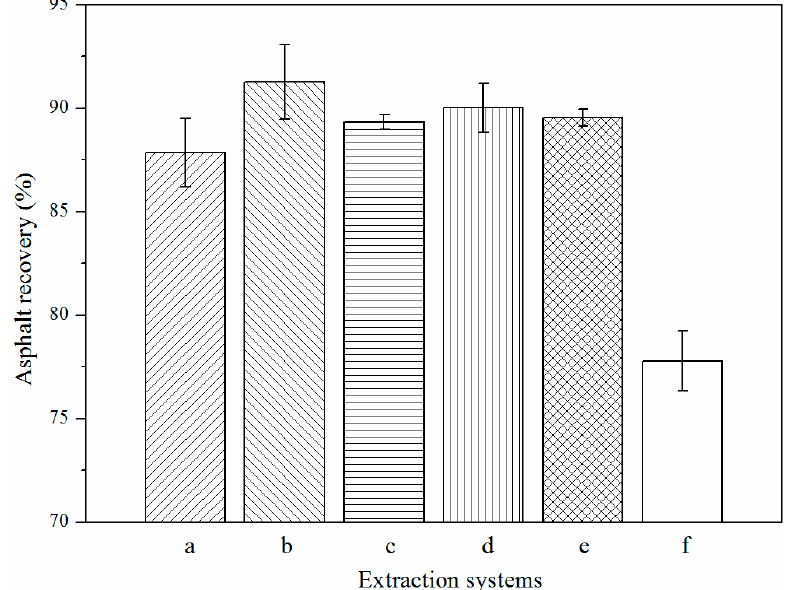
Figure 5. Asphalt recovery by solvent extraction by: (a) ChGly-toluene mixture, (b) ChHis-toluene mixture, (c) ChSer-toluene mixture, (d) ChPro-toluene mixture, (e) ChPhe-toluene mixture, and (f) toluene. Table 3. Surface tension of AAIL and interfacial tension of AAIL-toluene interface. ChGly ChHis ChSer ChPro ChPhe Surface tension of AAIL (mN/m)